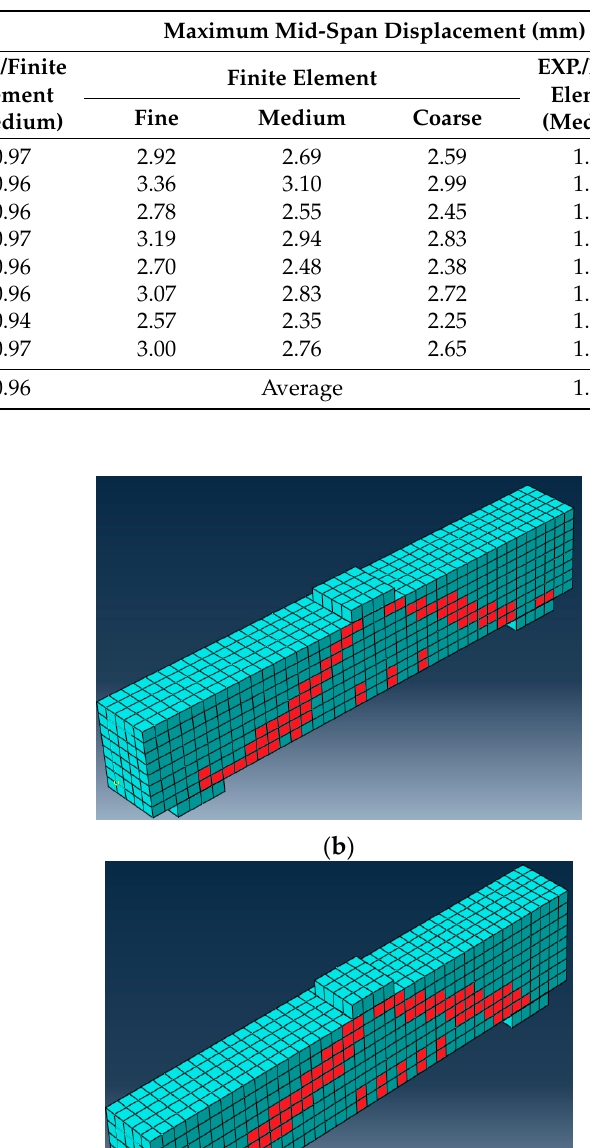
Table 10. Comparison of the experimental and finite element findings.